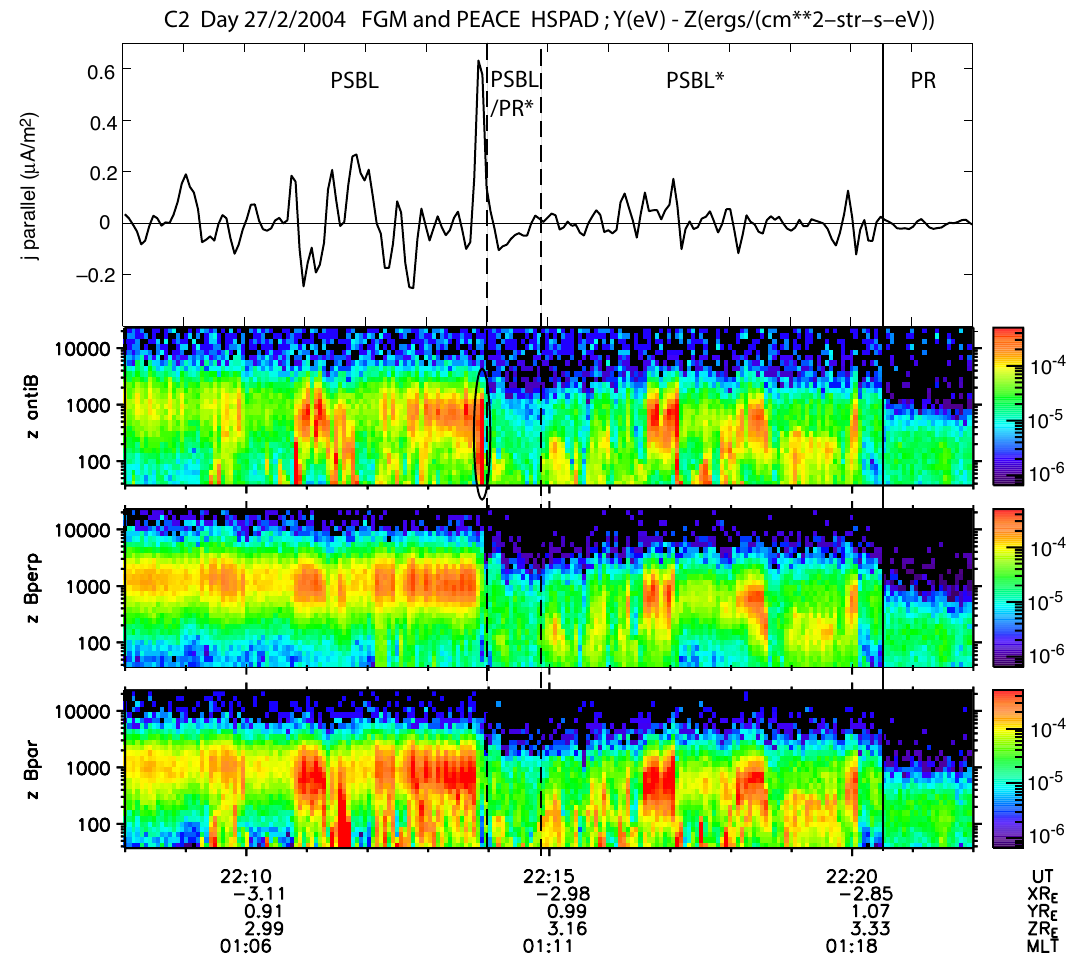
Fig. 12. Downward FAC for C2 (top panel) and PEACE data in the same format as Fig. 6 (bottom